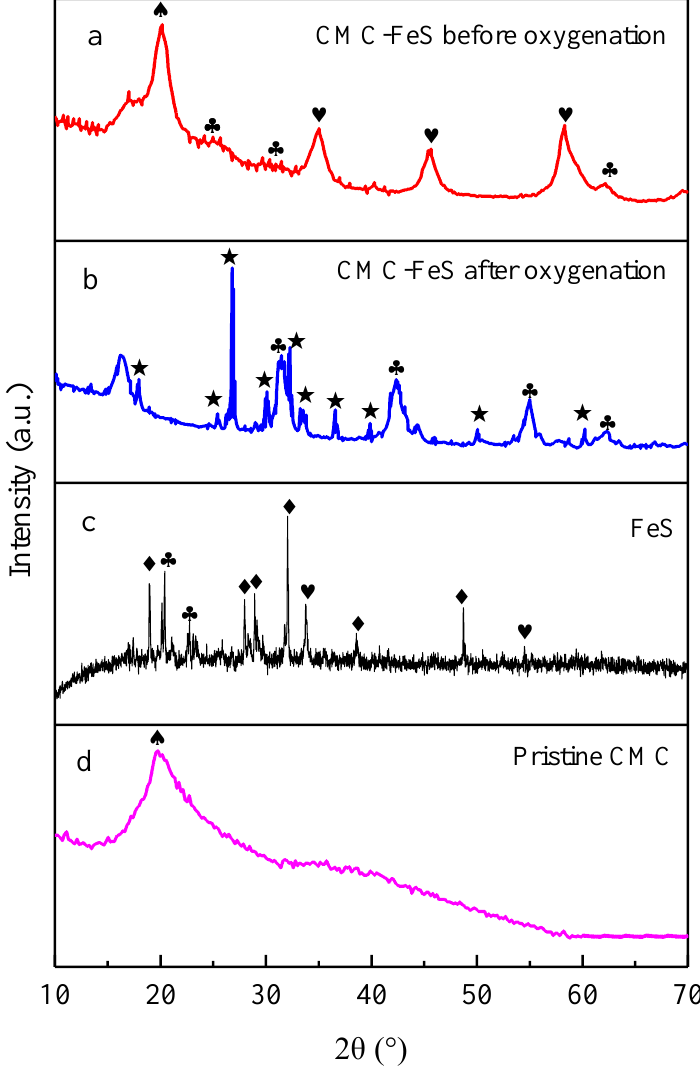
Figure 3. XRD patterns of pristine CMC ( a ), FeS ( b ), CMC-FeS before oxygenation ( c ), and CMC-FeS after oxygenation ( d ). ♣ : FeOOH; ♦ : Na 2 SO 4 ; ♥ : FeS; ♠ : CMC; ★ : Sulfur.